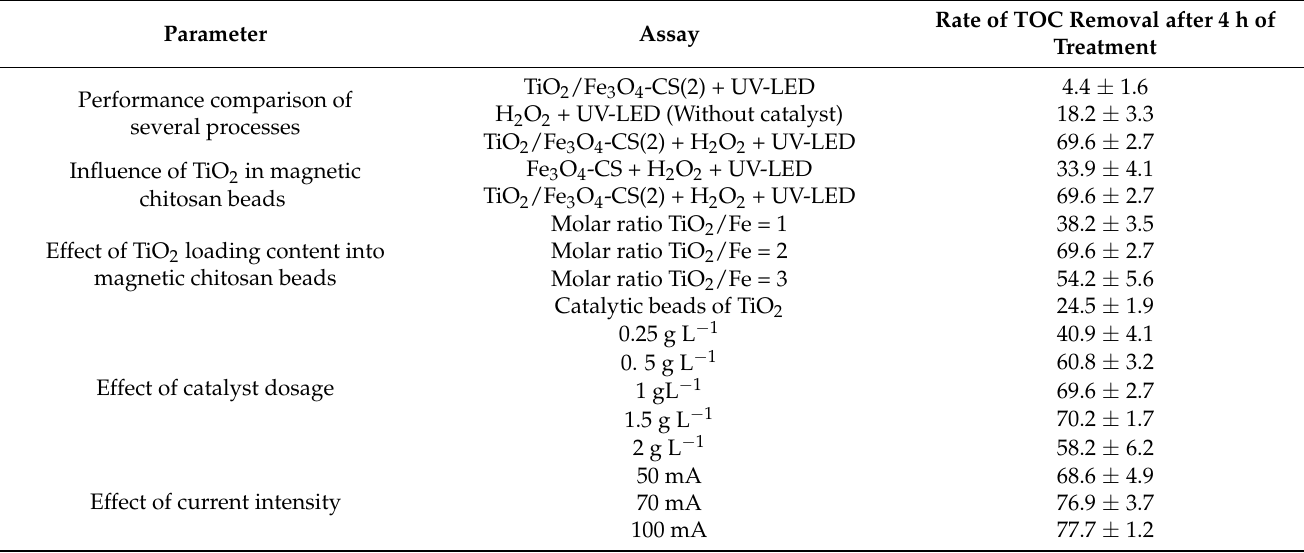
Table 1. Summary table of mineralization